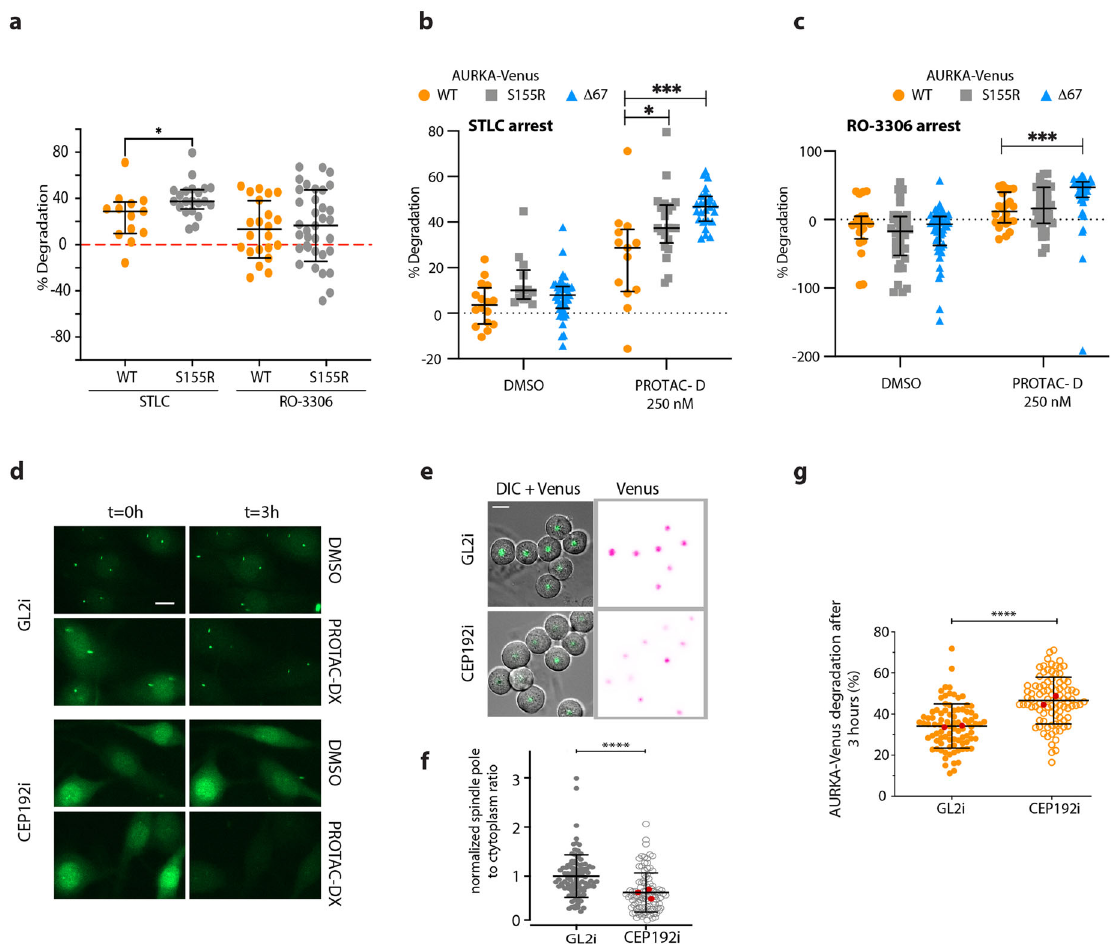
Fig. 6 Differential targeting of AURKA pools. a – c Differential degradation of AURKA-Venus variants in response to PROTAC-D. U2OS cells were transiently transfected with different versions of AURKA-Venus and treated for 16 h with RO-3306 to arrest them in G2 phase, or with STLC to arrest them in mitosis. Cells were then treated with 250 nM PROTAC-D or DMSO as vehicle control and subjected to fl uorescence timelapse microscopy over 3 h. Venus levels in whole cells were measured at the start and end of each experiment to calculate percentage protein remaining for each cell. Scatter plots show data from individual cells to compare wild-type and S155R versions ( a ) or wild-type, S155R and Δ 67 versions under conditions of mitotic ( b ) and interphase ( c ) arrest. Bars and whiskers represent mean values and SDs and are pooled from three repeats of the same experiment (unpaired t -test, n ≥ 10). d – g RPE1-AURKA-Venus KI cells were transfected for 48 h with siRNA against CEP192 (CEP192i) or control siRNA (GL2i) then either arrested in G2 phase with RO3306 ( d ) or arrested in mitosis with STLC ( e – g ) for 16 h before treatment with PROTAC-DX for 3 h. d Panels from start and end of experiment show AURKA-Venus preserved at centrosomes in control cells even following PROTAC treatment, but absent from centrosomes in CEP192i (See Supplementary Fig. S5 for quanti fi cation of this experiment). e Panels from start of experiment in STLC-arrested cells, showing reduced localization of AURKA to the single spindle pole in each cell following CEP192i, as quanti fi ed in f : Mean pixel intensities of AURKA-Venus were measured within a region of interest of fi xed diameter around poles and in the cytoplasm, and are expressed as the ratio of spindle pole:cytoplasm after normalization of each dataset with the mean value of the control sample. Data from individual cells in three independent repeats of the experiment were pooled, with the mean value of each repeat plotted in red and tested for statistical signi fi cance using Mann – Whitney U -test. g In mitotic-arrested cells AURKA-Venus KI showed strongly enhanced degradation after CEP192 knockdown in live cell degradation assays: Plots show percentage degradation in individual cells after 3 h treatment and contain pooled data from two independent experiments with mean values from each experiment plotted in red (Mann Whitney U -test). A third independent experiment was carried out, showing the same result but with response to PROTAC reduced in all conditions, with the pooled data shown in Supplementary Fig.